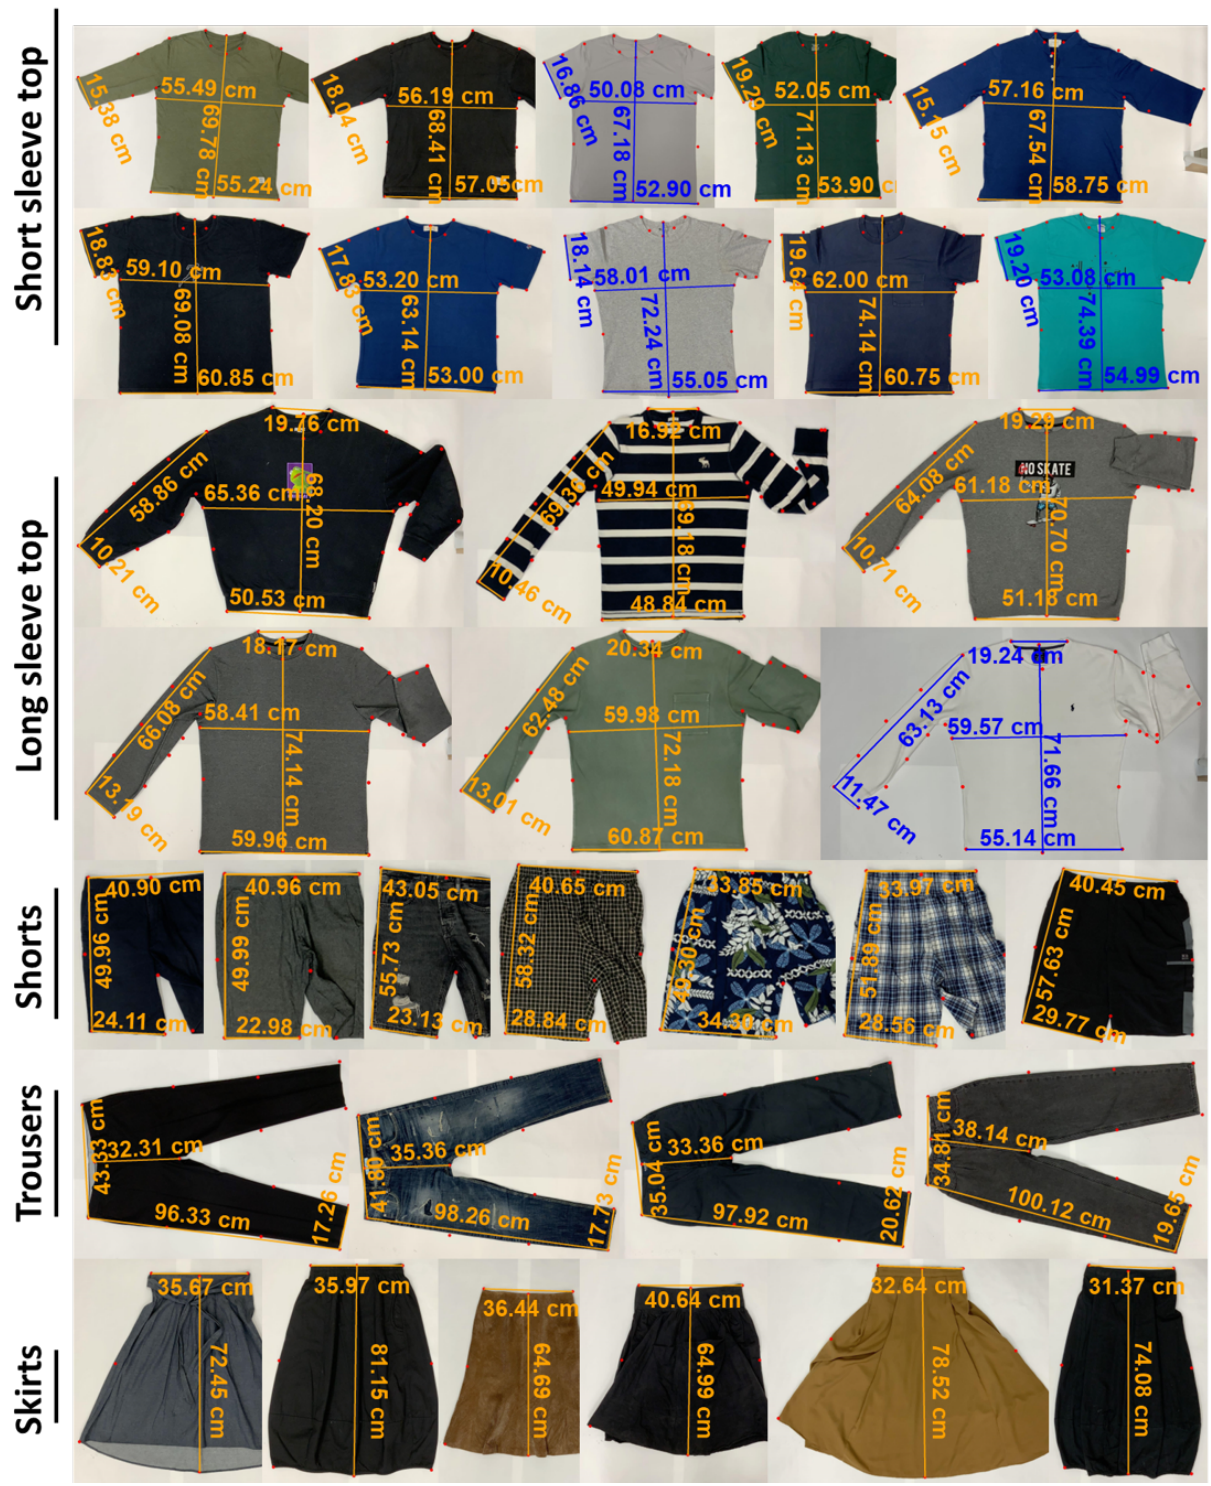
Figure A2. Samples of Experiment 1 (on white background) results with 33 pieces of